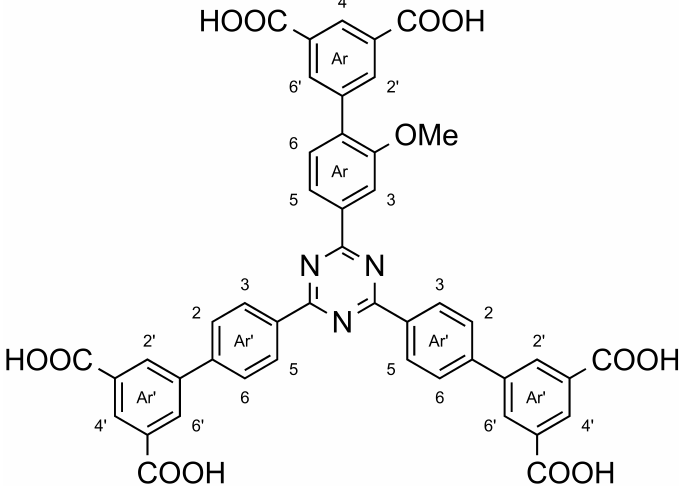
(cid:48) (cid:48) ,5 -bis(methoxycarbonyl)-biphenyl-4-yl]-4,6-bis[3